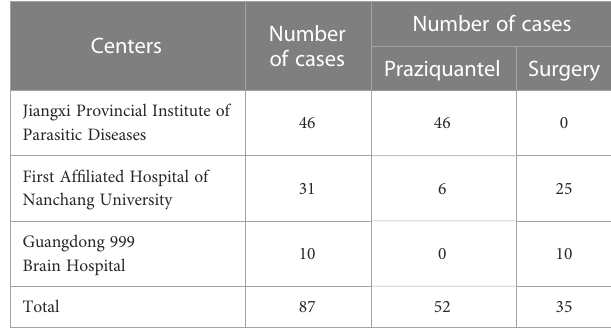
TABLE 2 Treatment of patients with cerebral sparganosis mansoni in three